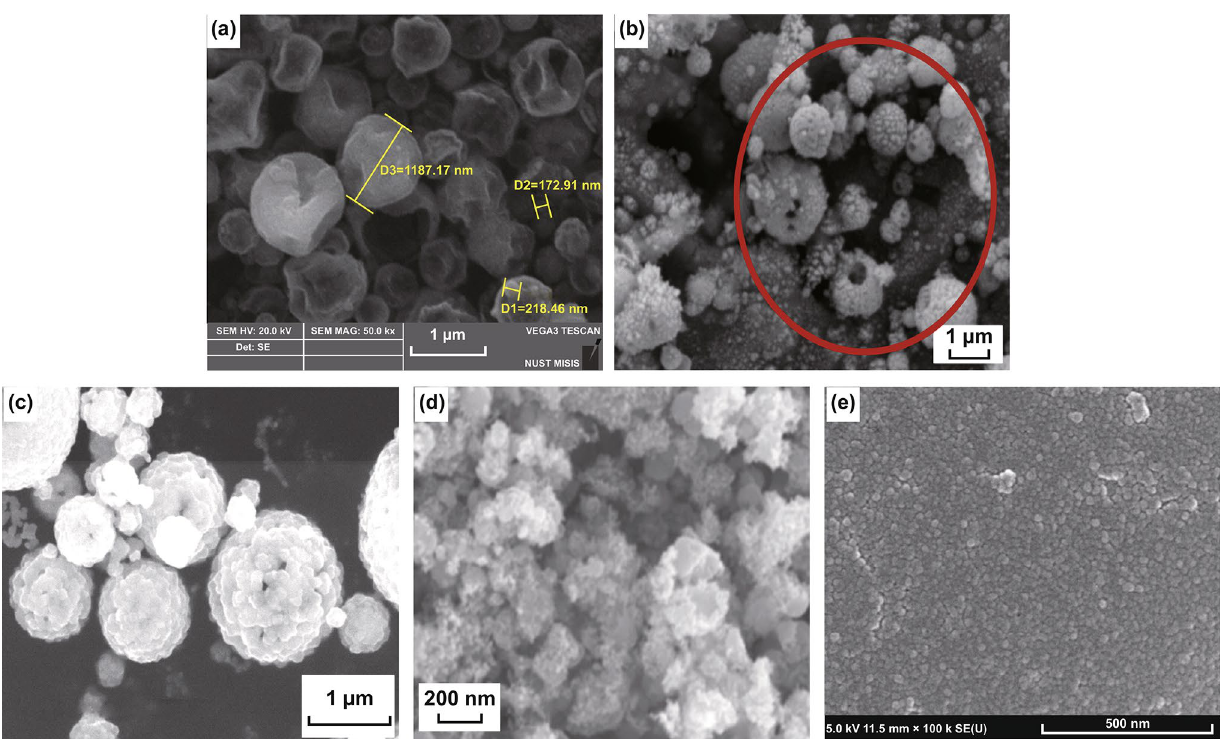
Fig. 21 Morphologies of various NiCo 2 O 4 nanostructures a hollow nanosphere. Reproduced with permission from Ref. [215]. Copyright © 2017 The Korean Society of Industrial and Engineering Chemistry, Published by Elsevier B.V. b hollow microspheres. Reproduced with permis- sion from Ref. [216]. Copyright © 2019 Elsevier Ltd and Techna Group S.r.l. c yolk–shell microspheres. Reproduced with permission from Ref. [218]. Copyright © 2017 Elsevier Ltd. d nanoaggregates. Reproduced with permission from Ref. [219]. Copyright © 2015 Elsevier Inc. and e thin films with uniform particle distribution size 20–30 nm. Reproduced with permission from Ref. [220]. Copyright © 2016 Elsevier